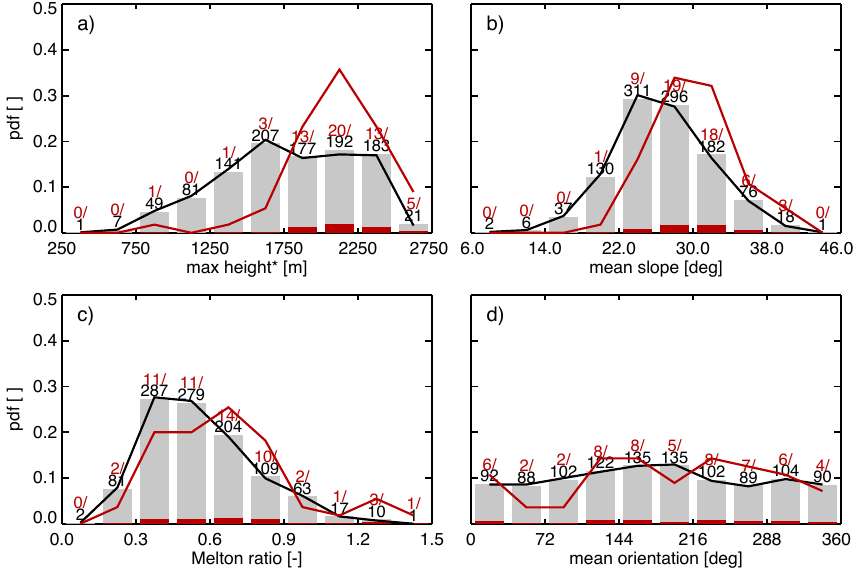
Figure 4. Histograms for the four geomorphological variables used for susceptibility assessment. (a) (cid:49)h max , (b) mean slope, (c) Melton ratio and (d) mean orientation of the subbasin. The red bars correspond to reactive subbasins. The black labels indicate the number of subbasins in each class (the red labels indicate the number of reactive subbasins). The lines show the probability distribution functions, h k,r (x) , for non-reactive and reactive subbasins (black and red lines,